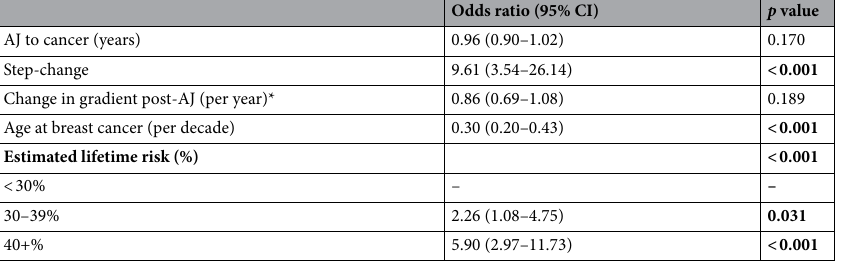
Table 4. Multivariable analysis of CRRM. Results are from a multivariable binary logistic regression model. All factors in Table 1 were initially considered for inclusion in the model, with forwards stepwise approach used to select those that were independently associated with CRRM. Factors selected by the stepwise procedure were then entered into a model alongside the factors from Table 2. Bold p values are significant at p < 0.05. *Represents the difference between the gradients in the pre- vs. post-AJ periods. Re-parameterisation of the model found the gradient in the post-AJ period to have an odds ratio of 0.83 per year (95% CI 0.67–1.02, p = 0.076).